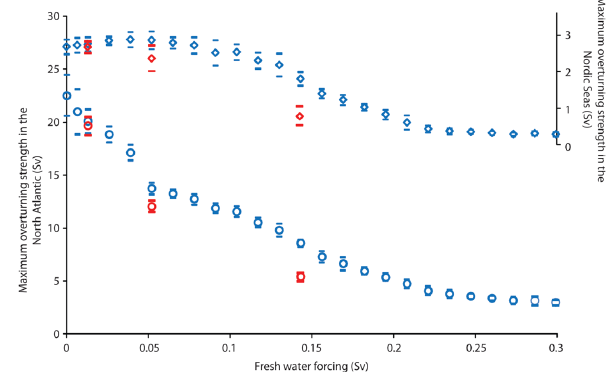
Fig. 3. The maximum strength of the overturning streamfunction (Sv) in the North Atlantic (circles) and Nordic Seas (diamonds) as a function of the freshwater forcing (Sv) from the GIS. The blue (red) symbols indicate simulations without (with) including changes in the elevation and extent of the GIS. Horizontal bars indicate the 95% confidence interval (2 σ ). All values are calculated over the last 150yr of the simulations. Simulated pre-industrial values are 23.65 ± 0.97Sv and 2.76 ± 0.17Sv for the maximum overturning strength in the North Atlantic and Nordic Seas